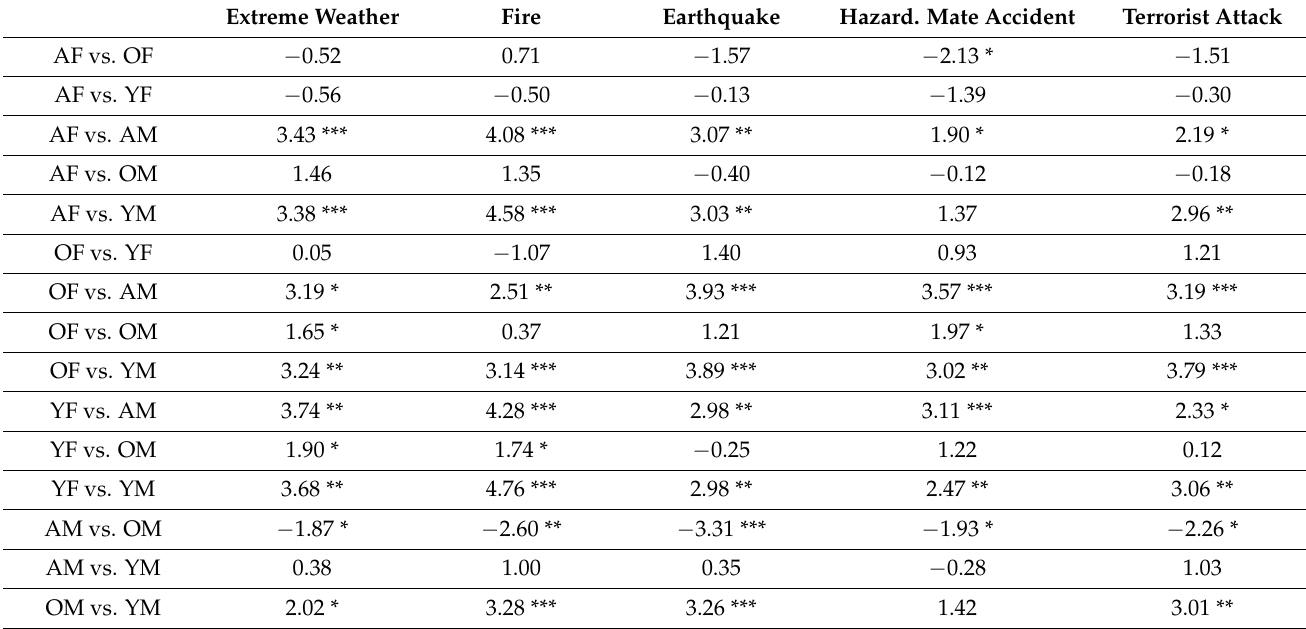
Table 9. Results of pairwise comparison using Dunn’s test (z-statistic and p -values) for risk perception according to gender and age ( α = 0.05). Grey cells indicate significant differences between subgroups for all hazards.